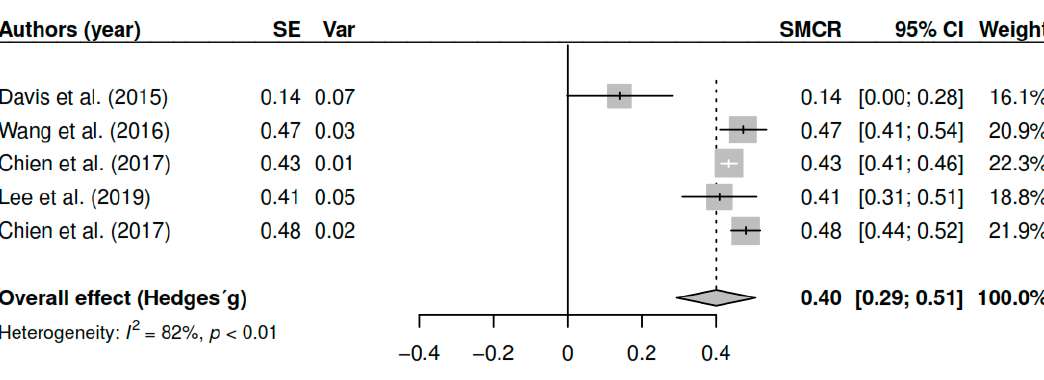
Figure 5. Forest plot for the model of random-effects and the values of Hedges’ g statistics in the negative symptoms variable (pretest–posttest).